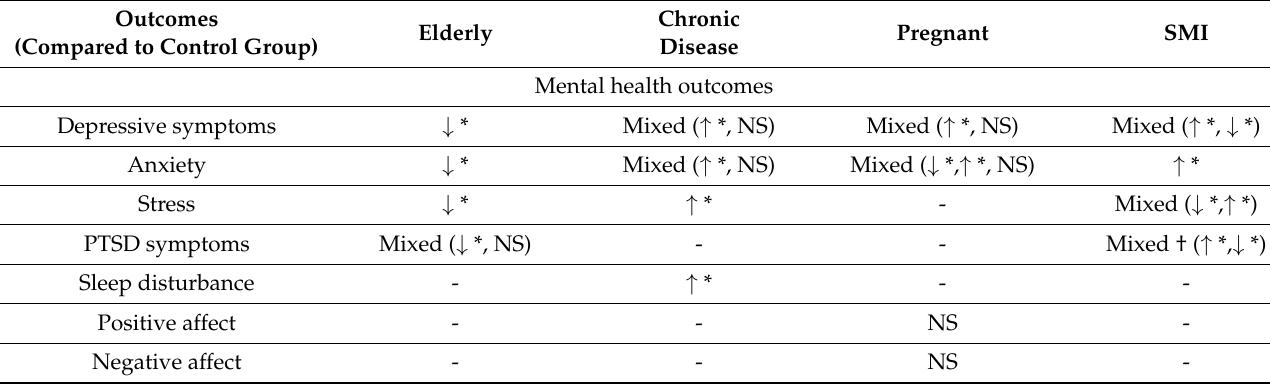
Table 3. Summary of results of included